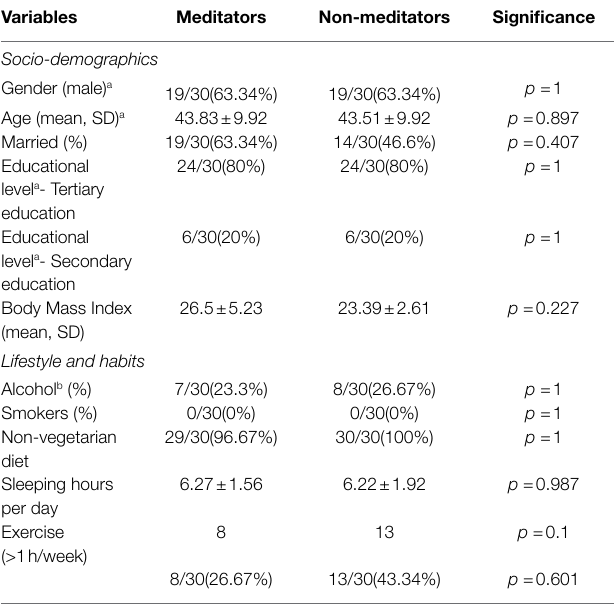
TABLE 1 | Socio-demographic and health characteristics of the study